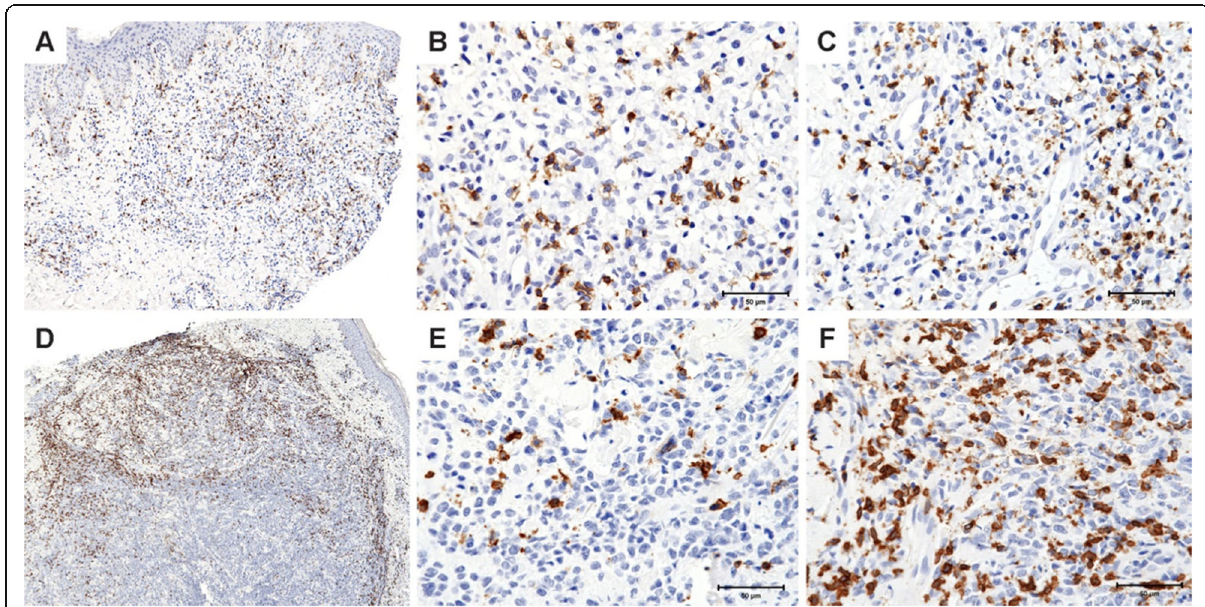
Fig. 2 CD8 density in lymphomatoid papulomatosis (LyP) and primary cutaneous anaplastic large cell lymphoma (pcALCL): a - LyP showed a regular distribution of CD8 positive cells between center and edge topographies (100X). b - Density of CD8 positive cells in the center of LyP (400X). c - Density of CD8 positive cells in the edge of LyP (400X). d - The density of CD8 is higher in the edge of pcALCL than in the center